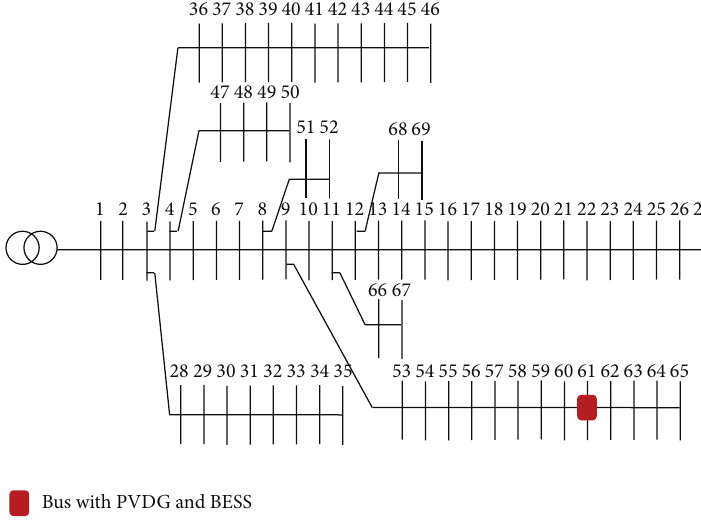
Figure 5: Single-line diagram of the 69-bus distribution system.